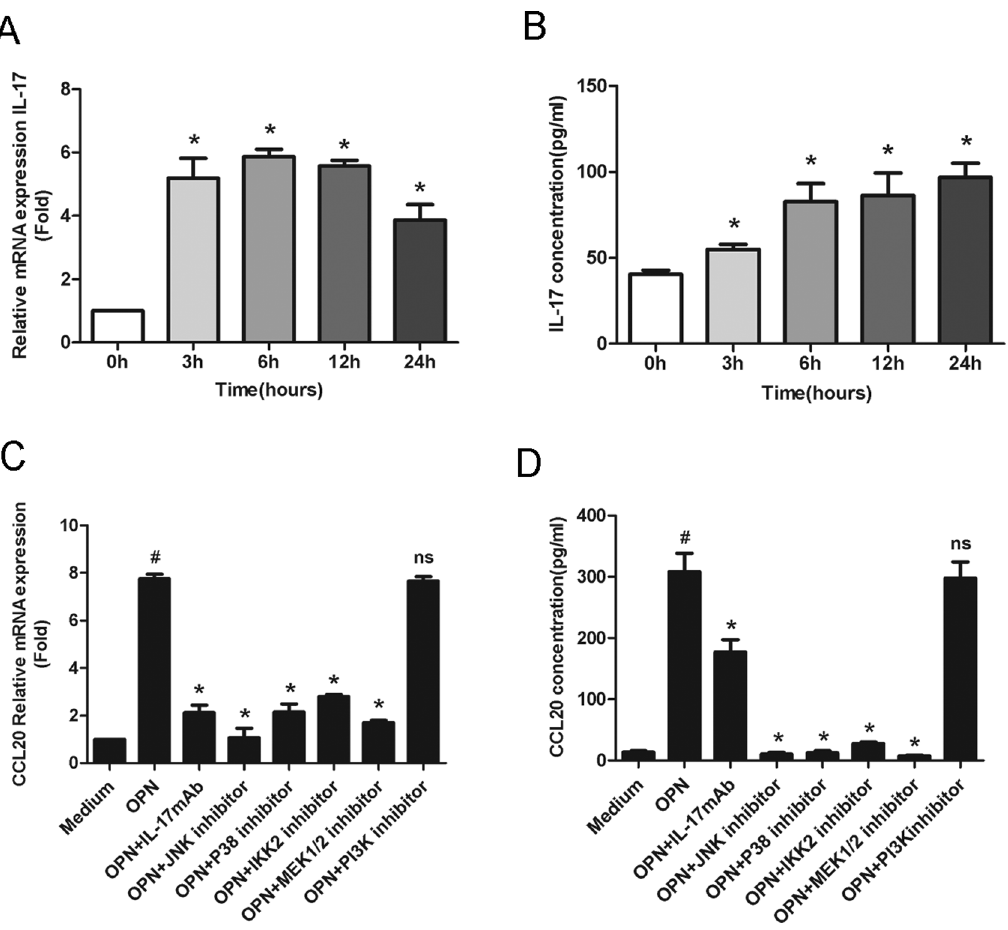
Figure 5. Effect of OPN on induction of CCL20 expression was mediated by IL-17, NF- k B and MAPK pathways. (A, B) PBMCs were isolated from normal subjects and treated with rOPN (1 m g/ml) at different time point. The IL-17 mRNA expression in purified CD4 + T cells (A) and protein level in culture medium (B) were analyzed. Induction of CCL20 mRNA in CD4 + T cells (C) and protein levels in culture medium (D) by OPN was blocked by antibody against IL-17, and inhibitors of IKK and MAPKs. Shown are representative results from 3 independent experiments with separate specimens. All data were presented as mean 6 SEM. *, P , 0.05 versus OPN; # P , 0.05 versus medium control; ns . 0.05 versus OPN.